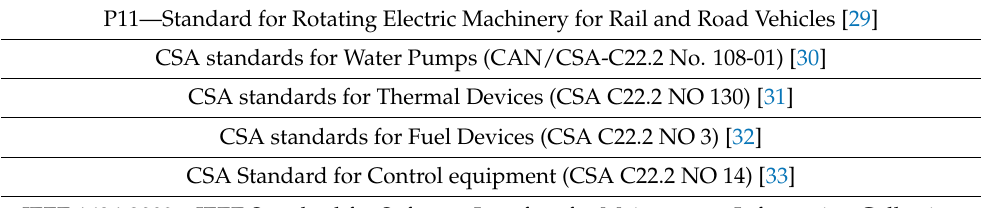
Table 3. Standards related to interfaces of interconnected